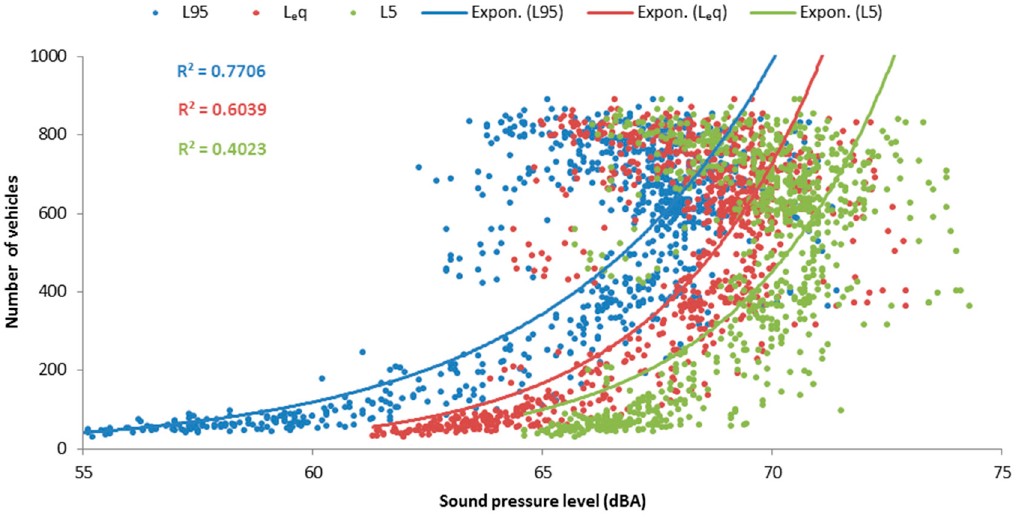
Figure 4. Exponential associations between sound levels and number of vehicles (on 5-min intervals).